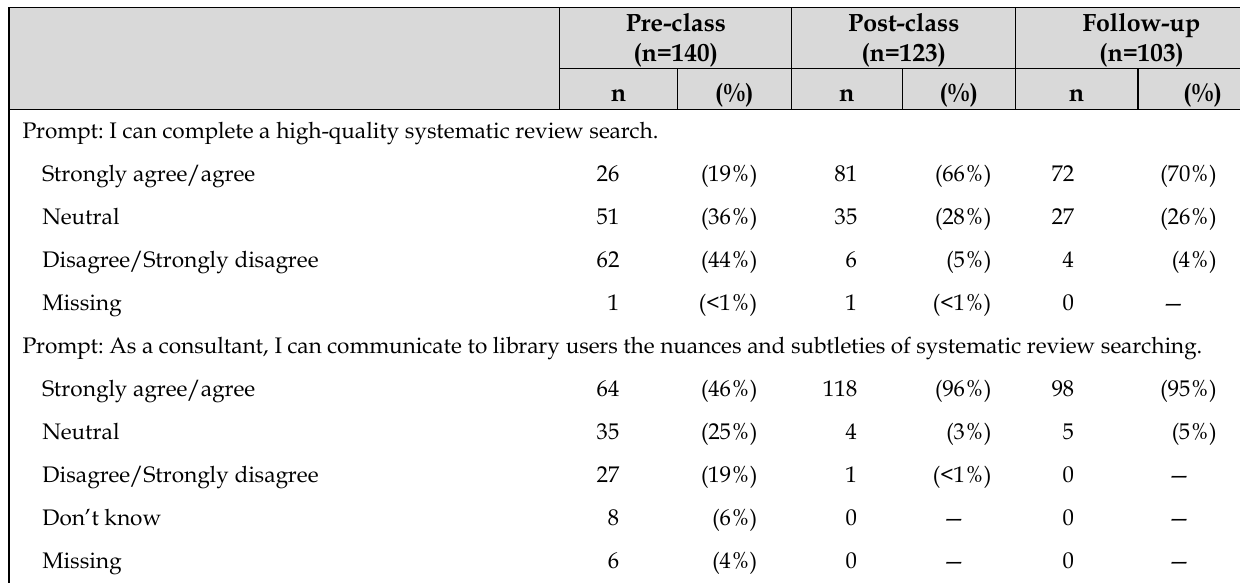
Table 1 Confidence in systematic review skills